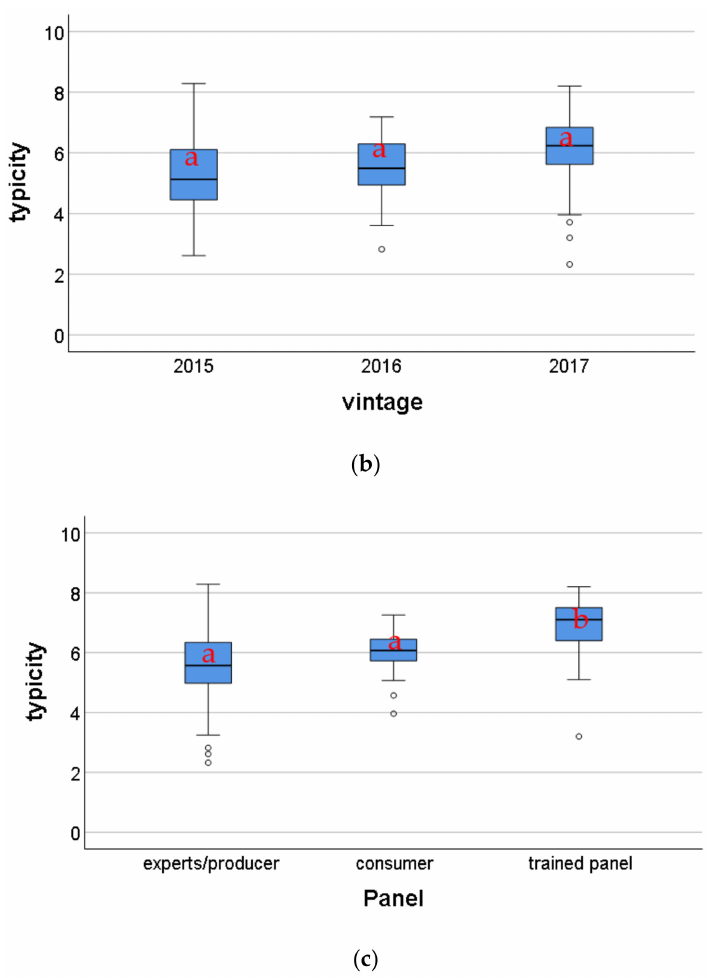
Figure 1. ( a ) Boxplot of the evaluated typicity of Pinot blanc wines from di ff erent regions: statistical di ff erences by pairwise comparison of the Mann-Whitney U tests ( α ≤ 0.05) after Bonferroni correction; di ff erent letters indicate significant di ff erences. ( b ) Boxplot of the assessed typicity of Pinot blanc wines from di ff erent vintages; statistical di ff erences by pairwise comparison of the Mann-Whitney U tests ( α ≤ 0.05) after Bonferroni correction; di ff erent letters indicate significant di ff erences. ( c ) Boxplot of the evaluated typicity of Pinot blanc wines evaluated by di ff erent panels; statistical di ff erences by pairwise comparison of the Mann-Whitney U tests ( α ≤ 0.05) after Bonferroni correction; di ff erent letters indicate significant di ff